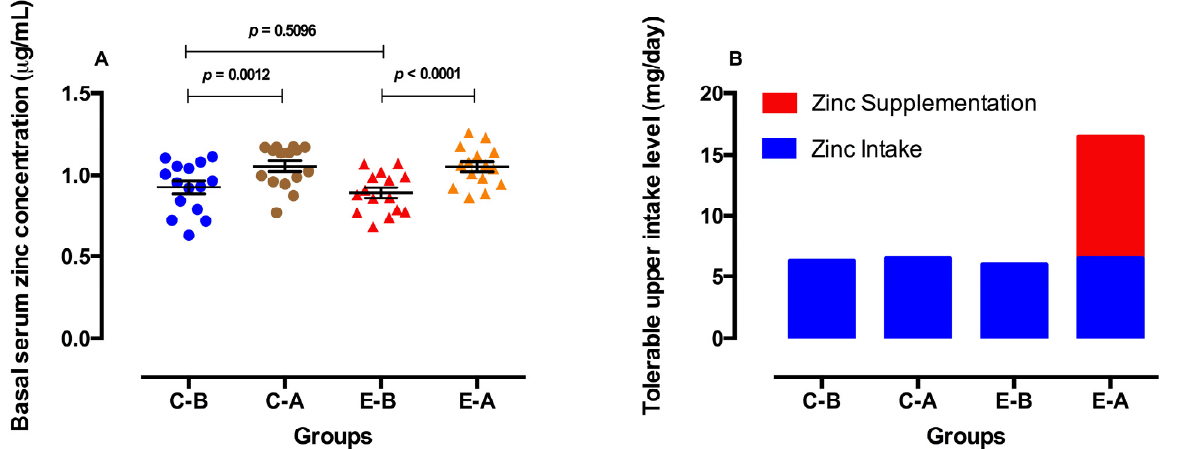
Figure 2. Basal serum zinc concentrations ( A ) and tolerable upper intake level of zinc ( B